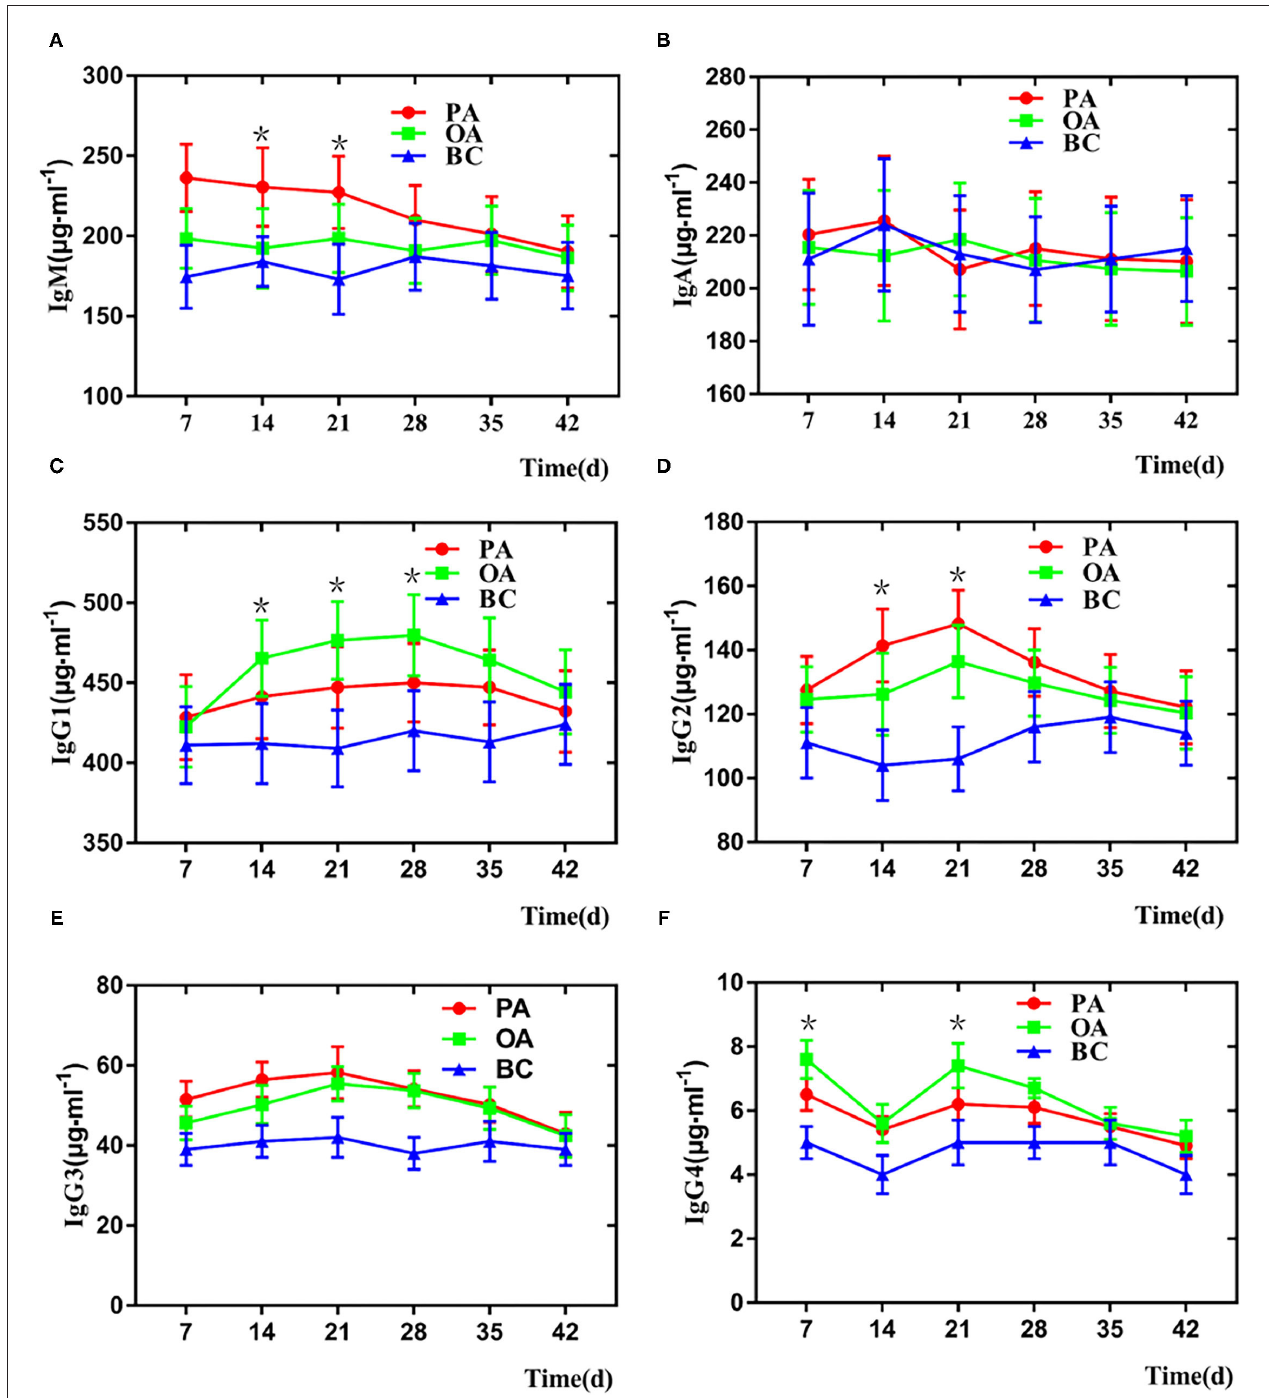
FIGURE 3 | Change of serum IgM and IgG in each group. (A) IgM, (B) IgA, (C) IgG1, (D) IgG2, (E) IgG3, and (F) IgG4. *There is a significant difference compared with BC group.